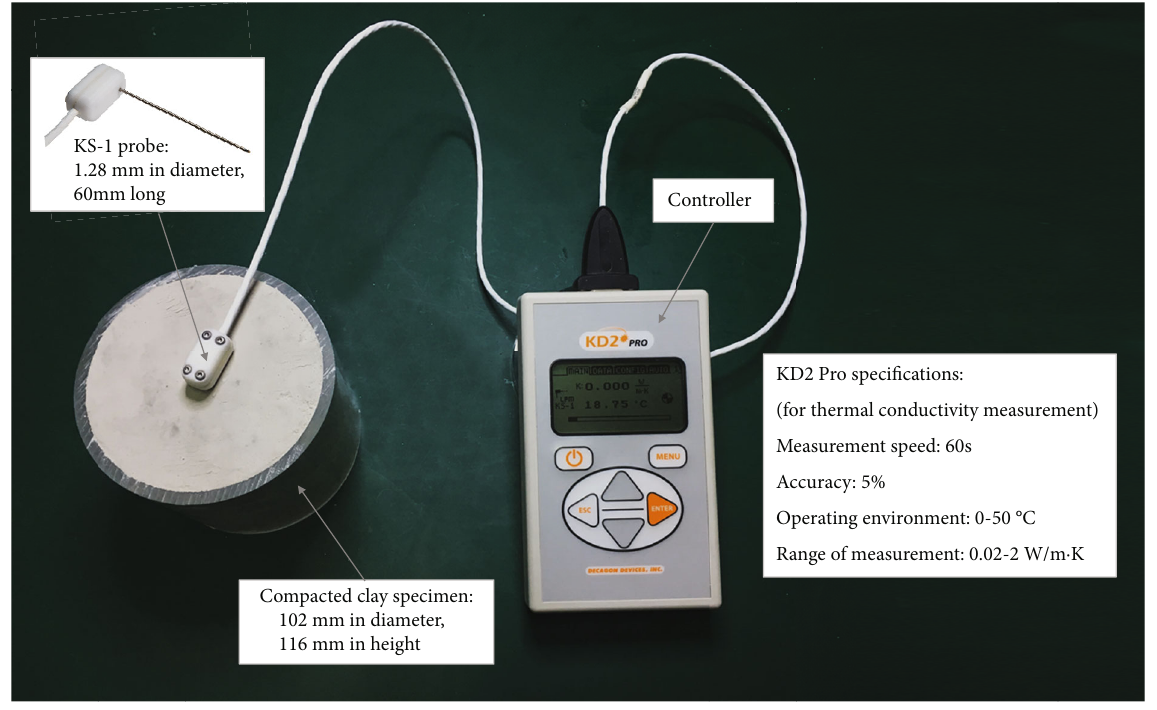
Figure 2: Measurement of thermal